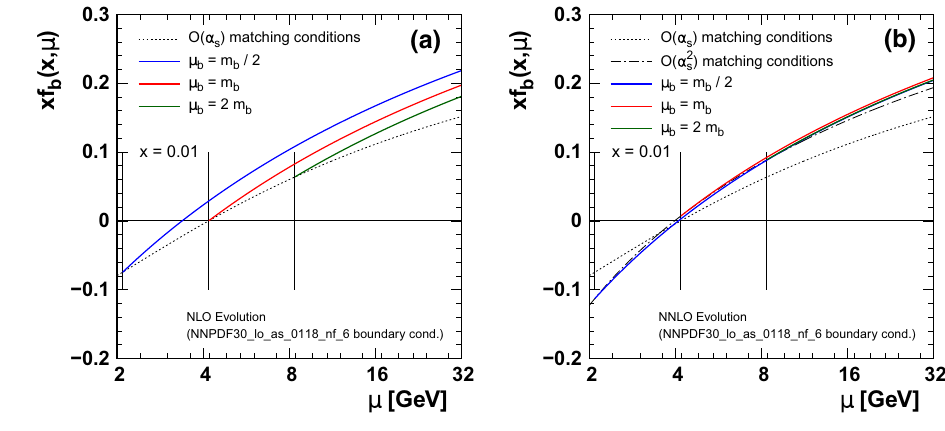
Fig. 3 We display the b-quark ( 5 ) ( x ,μ) for different PDF x f b choices of the matching scales μ = { m / 2 , m , 2 m } m b b b (indicated by the vertical lines) computed at NLO ( a )